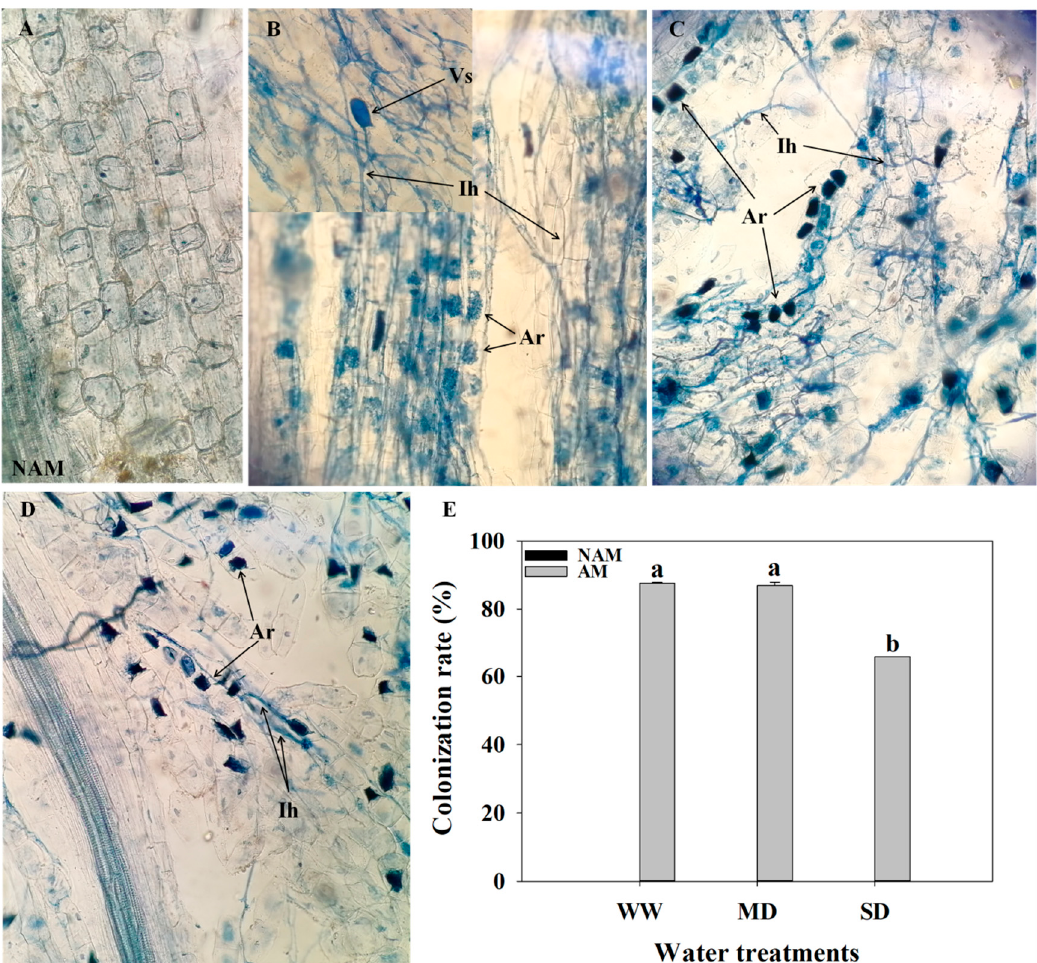
Figure 2. Development of arbuscular mycorrhizal fungus (AMF) Rhizophagus intraradices in Catalpa bungei seedling roots by Trypan blue staining. ( A ) The root of a non-inoculated plant. ( B ) Inoculated roots under well-watered (WW), ( C ) moderate drought (MD), and ( D ) severe drought (SD) conditions. ( E ) Colonization rate of mycorrhizal C. bungei seedlings. Ih, intraradical hyphae; Ar, arbuscule; Vs, vesicles; (A, B, C and D, G: ×400). NAM, non-AMF-inoculated; AM, AMF-inoculated. Different lowercase letters above the bars indicate significant differences ( p < 0.05) among treatments. Values are means ± SE ( n = 3).